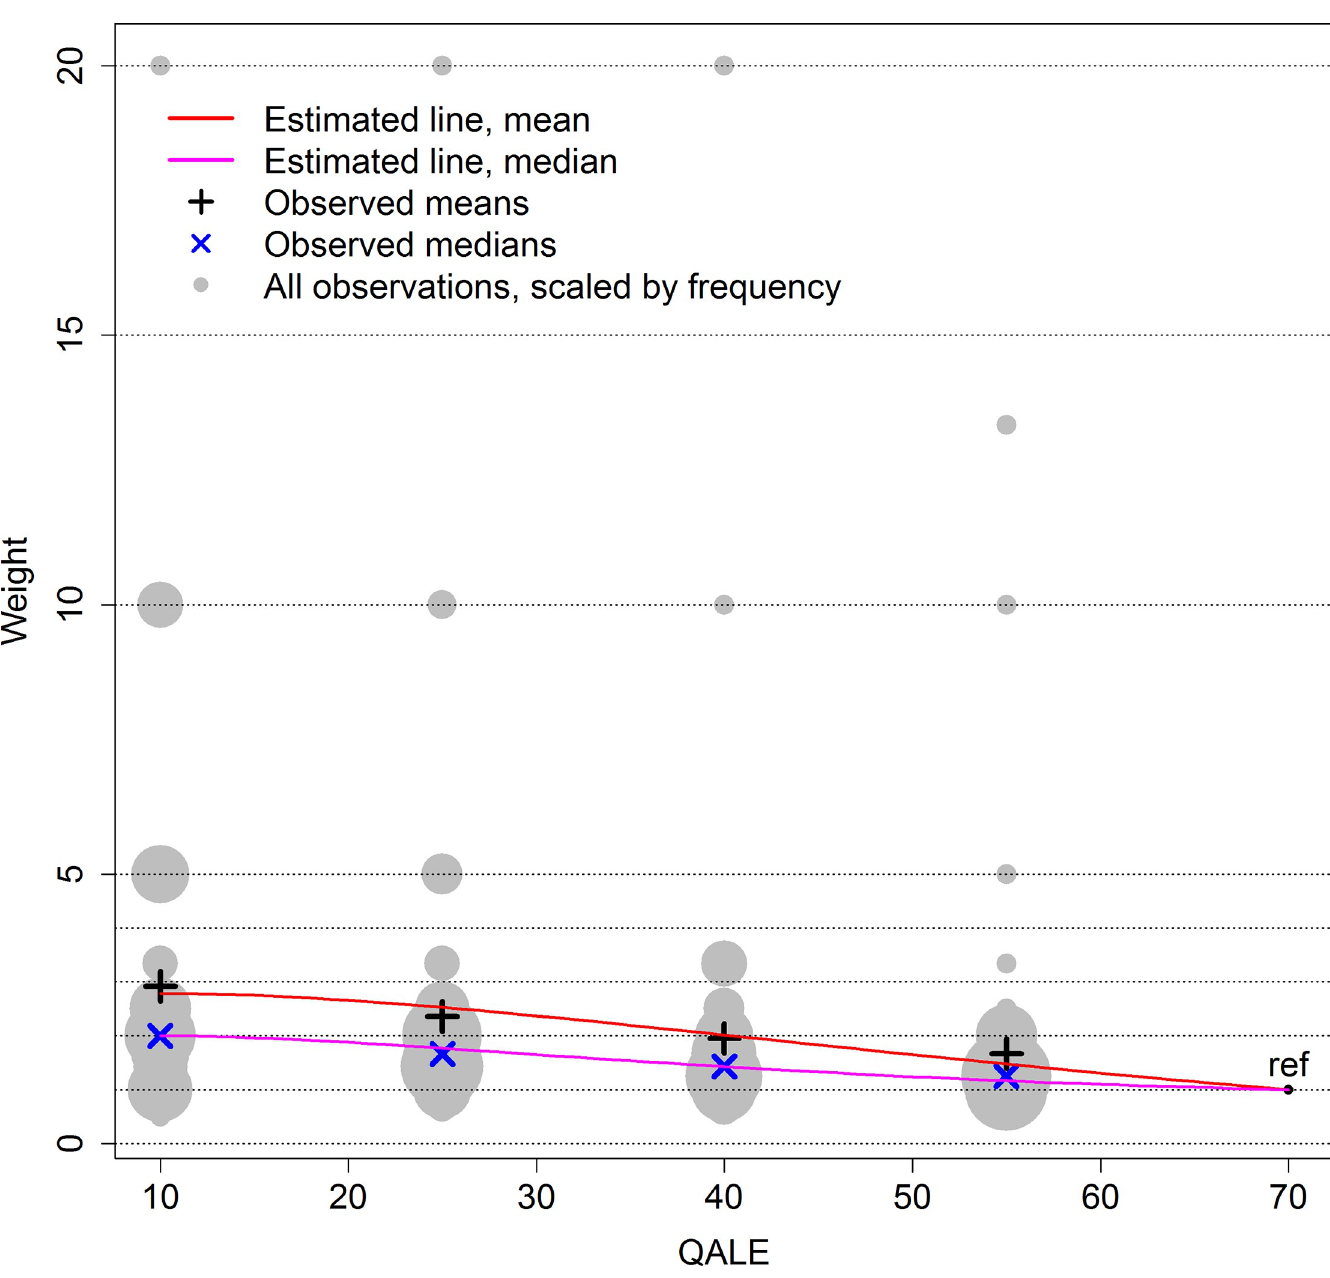
Fig 4. Estimating PW from data. The red line minimizes (8) to estimate a PW based on the means (black +). The coefficients are α = − 0.42, γ = − 22.2, C = 0.27, and β = 0.031. The pink line minimizes (10) to estimate a PW based on the medians (blue × ). The coefficients are α = 0.79, γ = − 8.85, C = 0.17, and β = 0.053. In both scenarios PW(10) = w m (maximum weight at T = 10) and PW is anchored at PW(70) = 1.